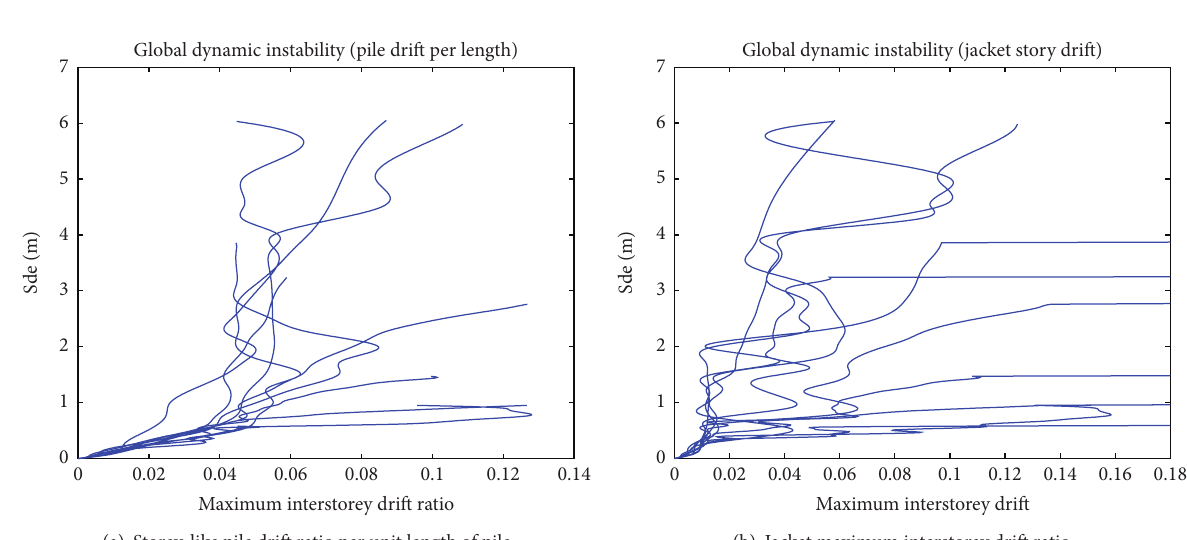
Figure 19: Multirecords IDA results of JS HE2